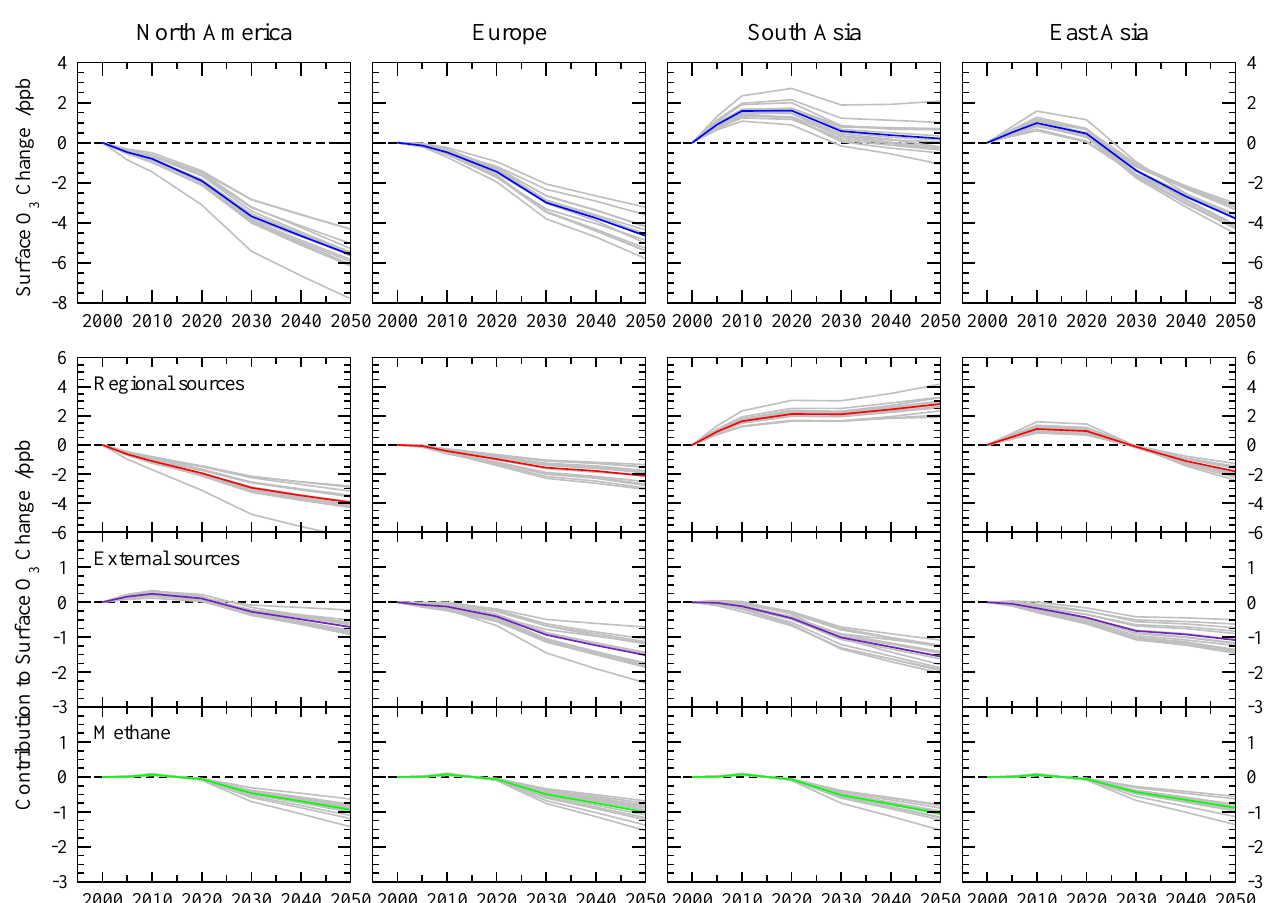
Fig. 9. Regional mean O 3 changes along the RCP 2.6 scenario showing the ensemble mean (coloured line) and individual model responses (grey lines). A source attribution is presented for each region in the lower